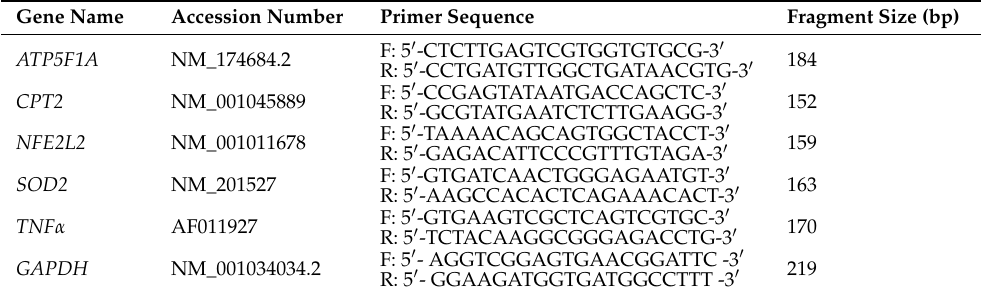
Table 1. List of oligonucleotide primers used for qRT-PCR